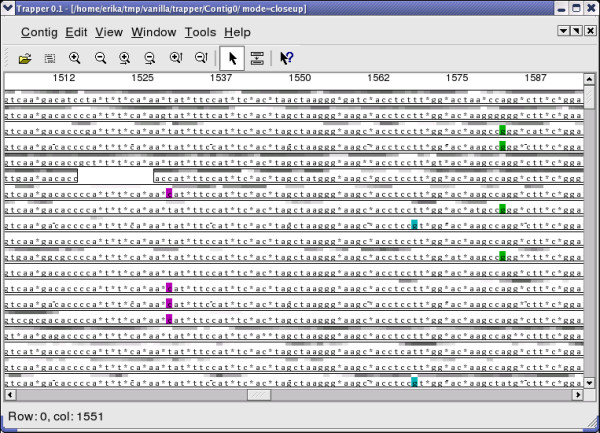
Zoomed in view of the simulated dataset. The different colors of the DNPs represent different DNP types. For instance, the light green DNPs indicate that the single base difference is an 'a' while the consensus base is a 'g'. This color coding makes it easy to observe DNP patterns in the alignment. Gaps are denoted by '*' in the alignment.